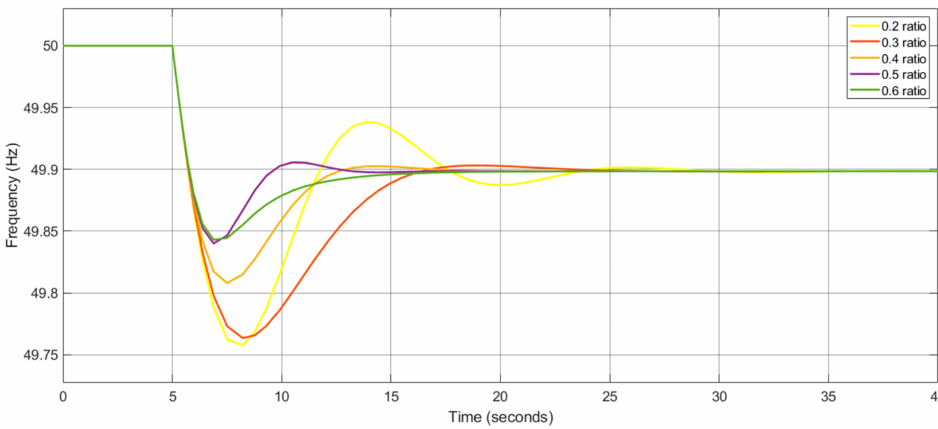
Figure 12. Impact of the high-pressure power fraction on the primary frequency